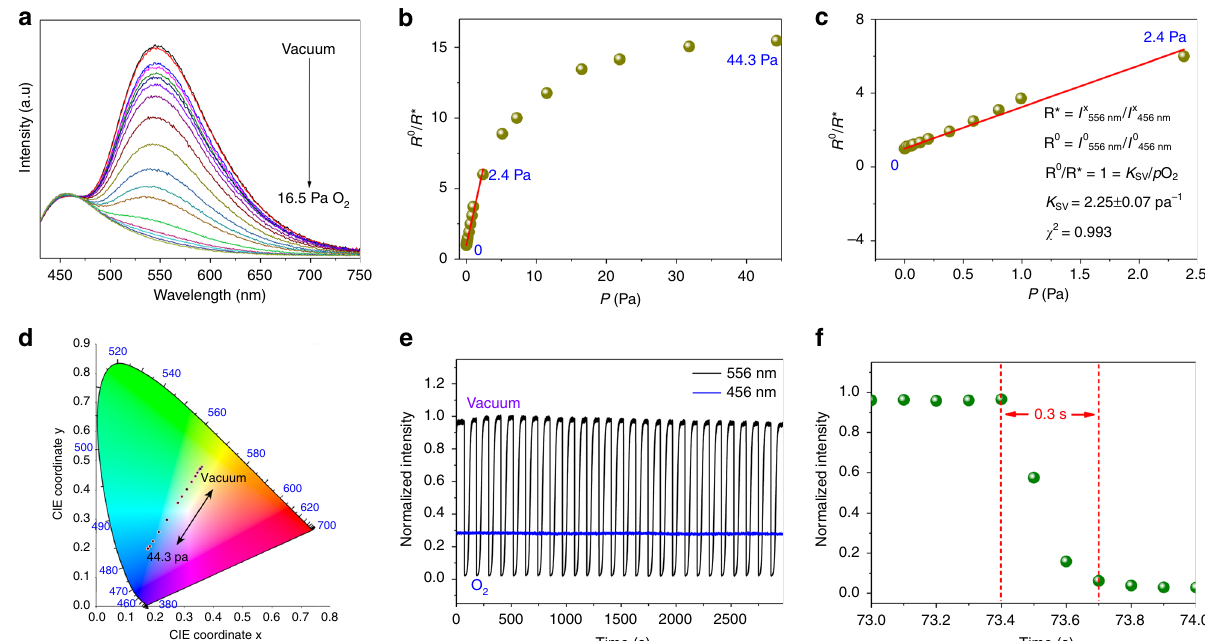
Fig. 3 Luminescent oxygen sensing. a Emission spectra of Ag 12 bpy-NH 2 under different oxygen pressures from 0 to 16.5 Pa (excited at 365 nm). b The correlation between the ratiometric photoluminescence response and O 2 partial pressure in the range of 0 – 44.3 Pa. c Representative Stern-Volmer plot of O 2 in the range of 0 – 2.4 Pa. d The emission color-changing range for ratiometric oxygen sensing. e Reversible luminescence cycles of Ag 12 bpy-NH 2 under alternating exposure to air/vacuum: on-off Ph (black folding line) and invariant Fl (blue straight line). f Enlargement of the response transient curves of Ag 12 bpy-NH 2 exposed to air. The response time of the air-quenching Ph component is ~0.3 s (the response time is de fi ned as the time corresponding to a 90% decrease in the emission intensity when the gas phase is changed from vacuum to